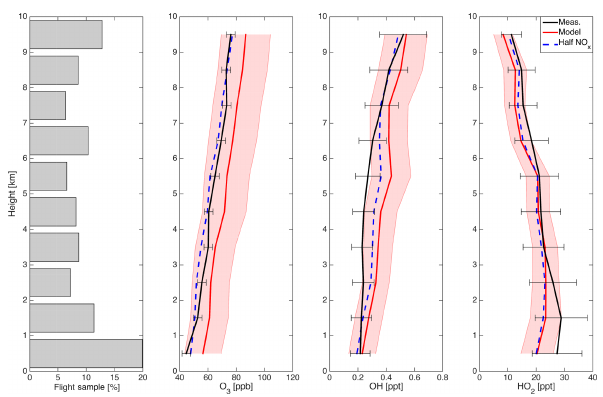
Figure 11. Vertical profiles of median modeled (red) and measured (black) ozone, OH, and HO 2 Houston-based INTEX-B flight data binned by kilometer. Gray bar graph shows percent of flight data within each vertical bin. Shaded regions represent 1 σ of model en- semble; error bars on measurements are uncertainty at 1 σ confi- dence. Blue line represents EPA-NEI and lightning NO x emissions reduced by